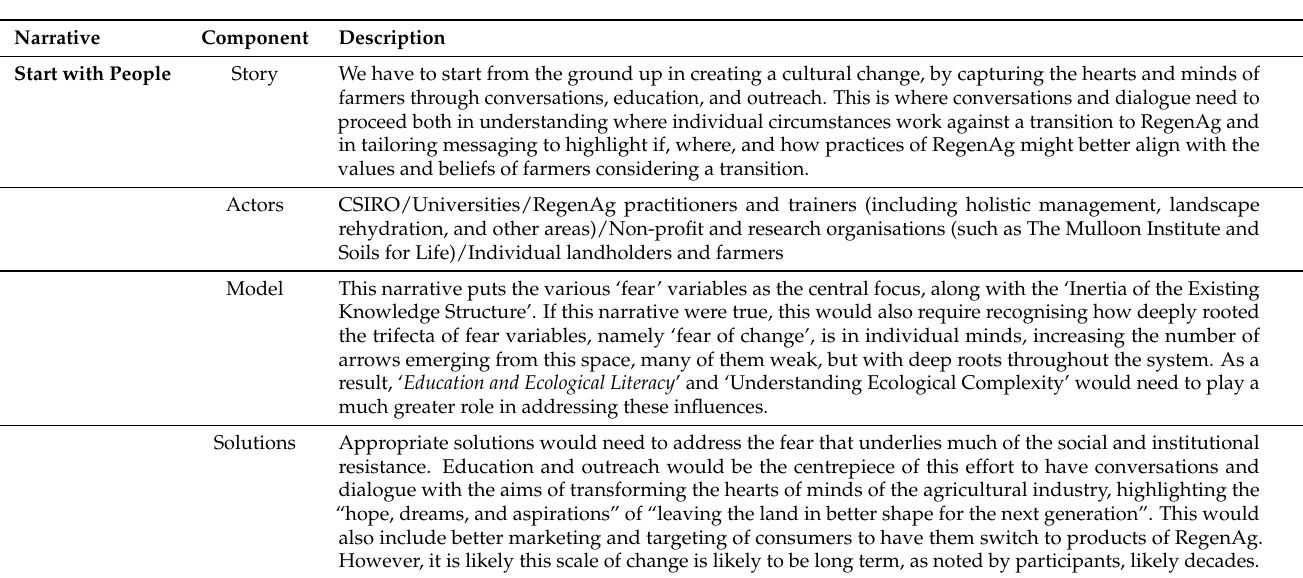
Table 6. Narrative 4: Start with